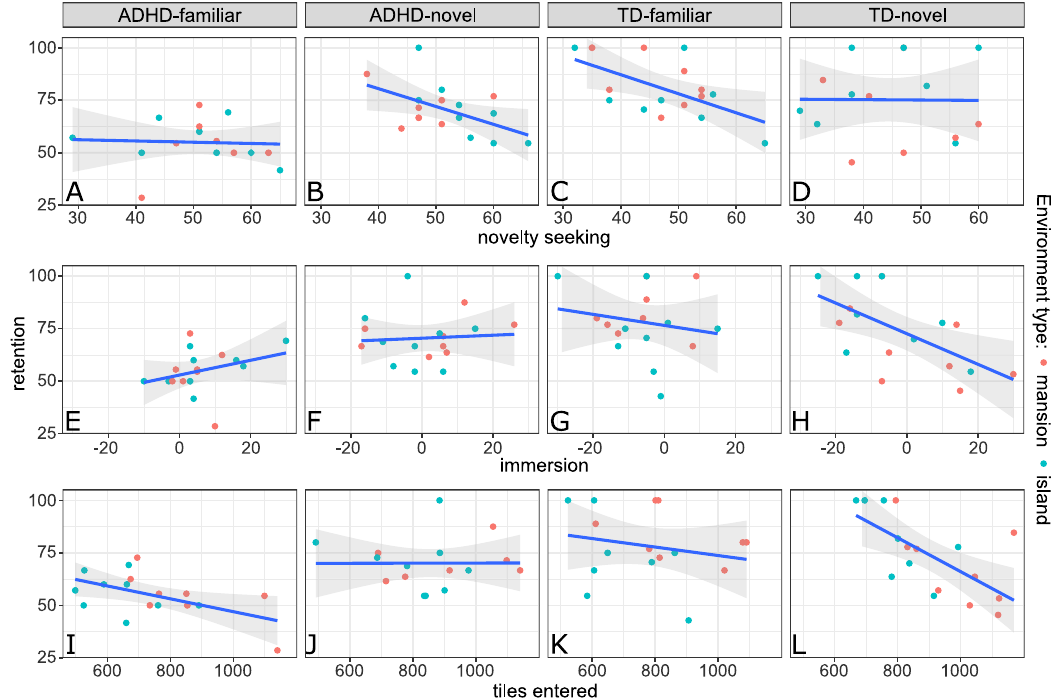
Figure 5. ( A – D ) Influence of novelty seeking on memory retention (exploratory excitability ratings, T-values), ( E – H ) influence of immersion (immersion ratings, raw scores) and ( I – L ) influence of exploration (number of tiles entered). In the TD-novel group, higher levels of exploration and immersion were associated with worse memory retention ( D , H ). Additionally, our data strongly suggested that this association was not present in the ADHD-novel group ( F , J ), indicating that the influence of exploration and immersion on memory retention might be different between children with and without ADHD. Note that here exploration, immersion and novelty seeking are shown on their original scales, while we z-transformed all three variables for the analyses reported in the text. Grey shaded areas indicate 95% confidence intervals, dots represent single participants. TD = typically developing, retention = LTM/STM *